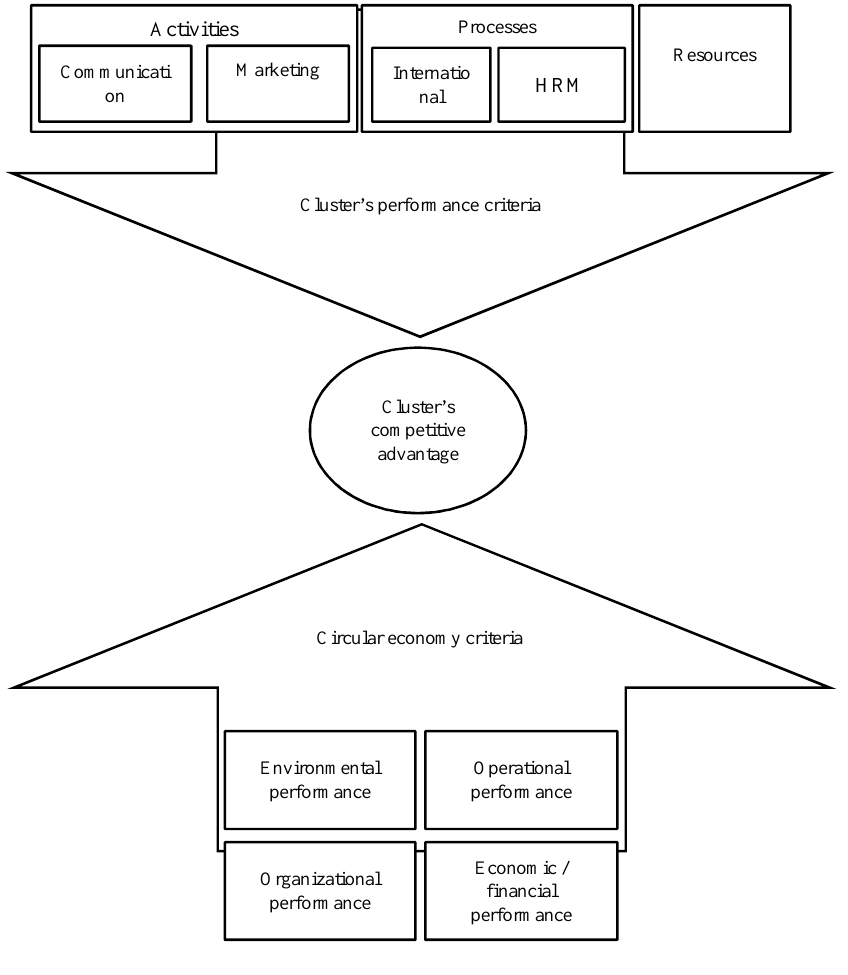
Figure 3. The scheme of the cluster's competitive